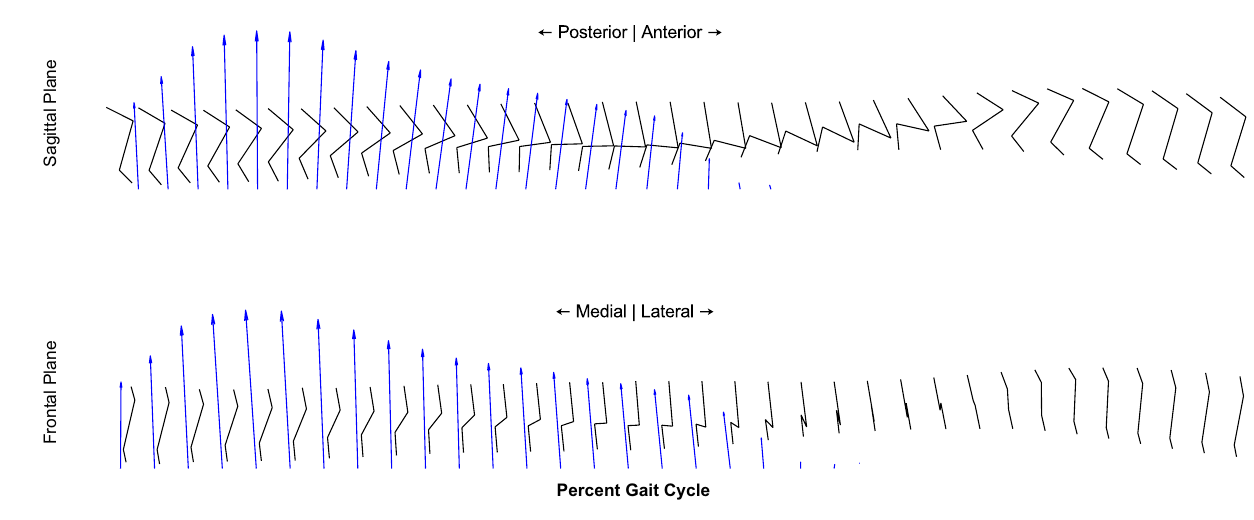
Figure 3. Ground reaction force (GRF) curves for healthy female Lewis rats. Curves are shown as mean + /− 1STD for all three axes (x, y, z). The X-axis is represented by the anterior/posterior forces, the Y-axis is represented by the medial/lateral forces, and the Z-axis is represented by the vertical forces. Data was compiled from load-cell footstrikes from 24 female Lewis rats.